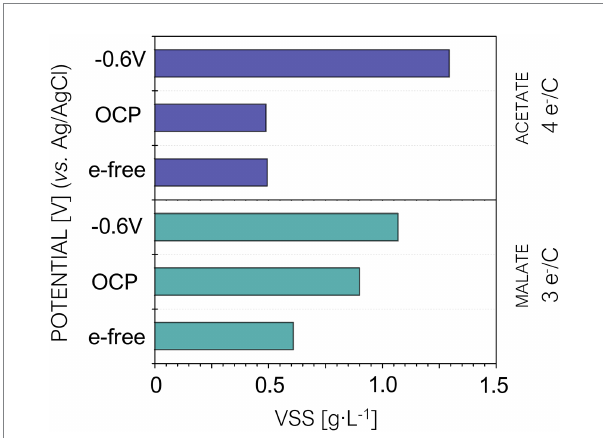
FIGURE 6 Volatile Suspended Solids (VVS) produced under electrode-free, open circuit potential (OCP) and –0.4 V (vs.